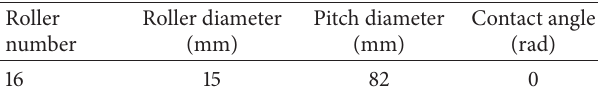
Table 1: Basic geometry information of the bearing.